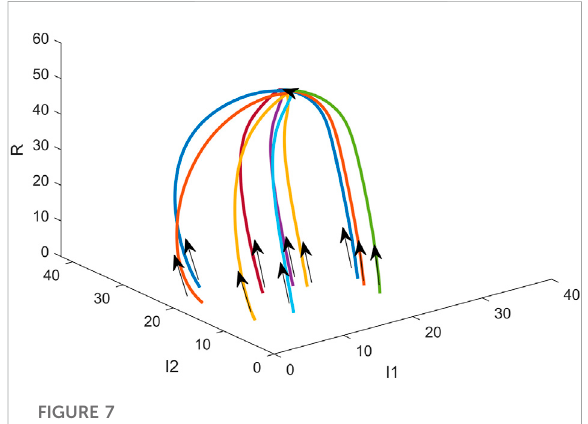
FIGURE 7 Propagation threshold validation for R 0 > 1.